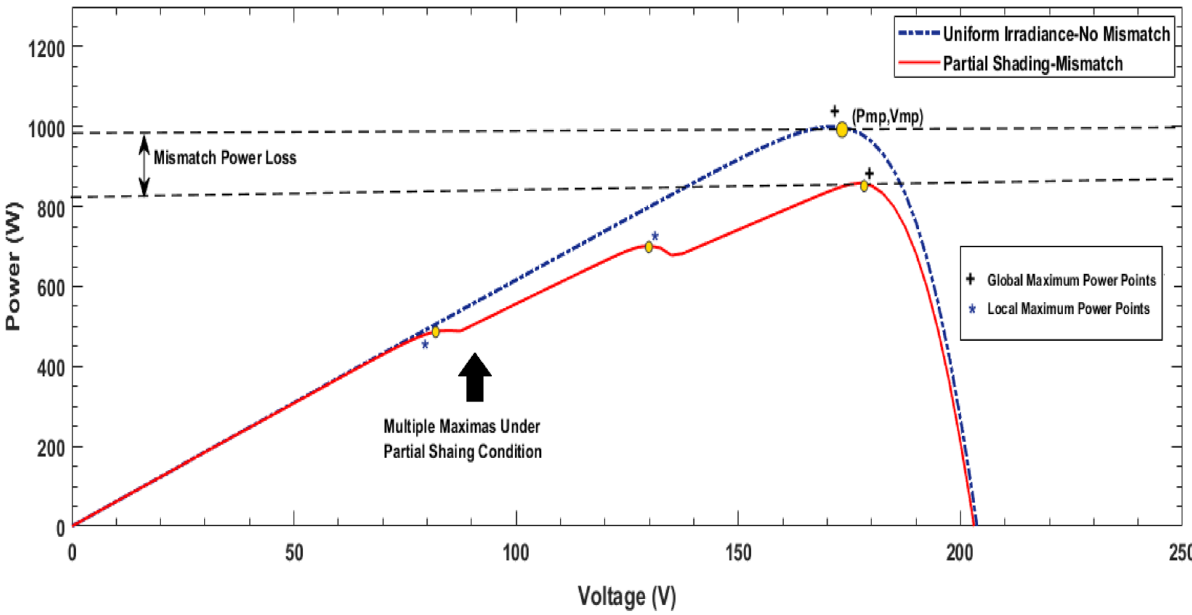
Fig. 1. Output power – voltage ( P – V ) characteristics of photovoltaic modules under STC and partial shading